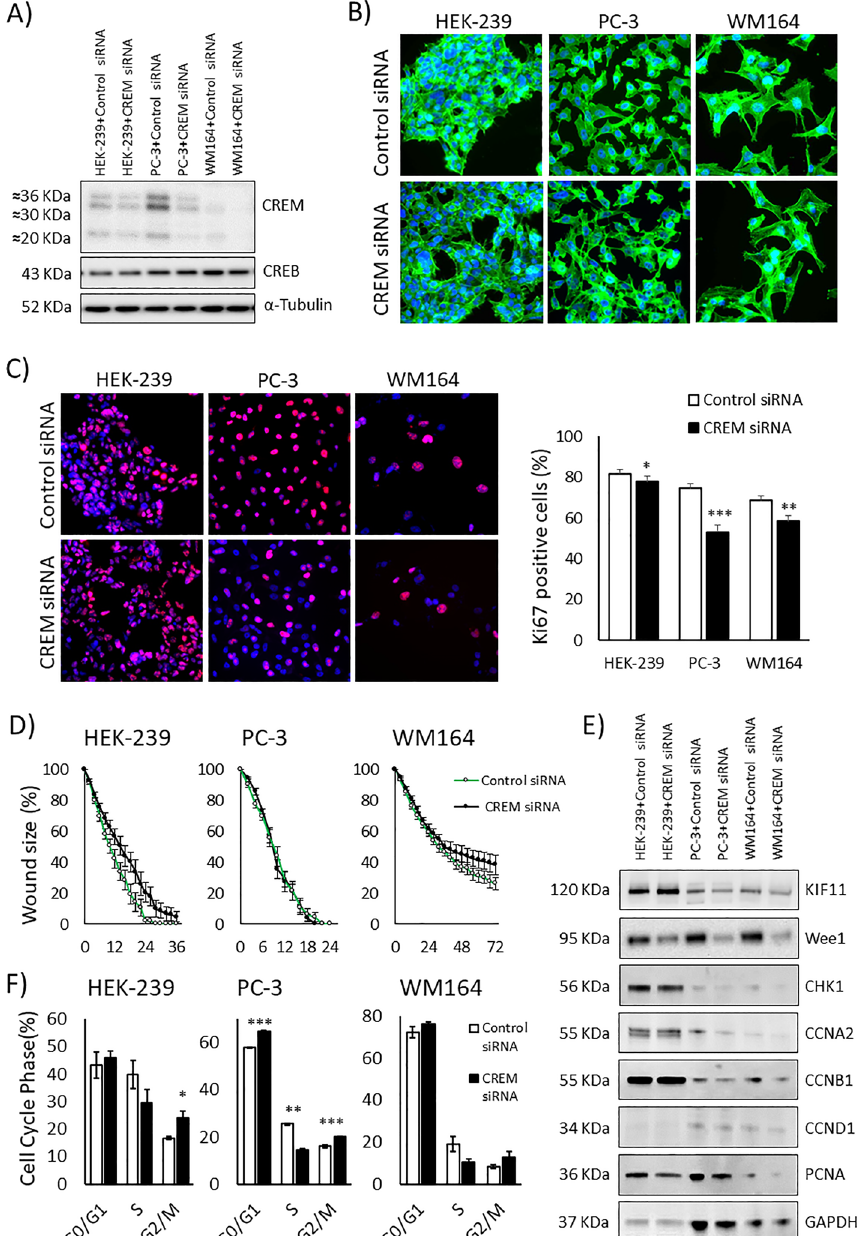
Figure 4. Wild type CREM knockdown. ( A ) Immunoblot showing Wild type CREM knocked down in HEK- 293, PC3, and WM164 after treatment with CREM siRNA for 48 h. The blots are cropped and original blots can be found in Supplementary information—Original blots Supplementary Fig. S8. ( B ) Cell morphology in HEK- 293, PC3, and WM164 cell lines after the reduction in CREM levels. ( C ) Proliferation assessed with Ki67 after CREM siRNA in HEK-293, PC3, and WM164 cell lines, it resulted with proliferation of loss from 82 to 78%, from 75 to 53%, and from 69 to 58%, respectively. ( D ) Wound healing assay to assess migration after CREM knockdown in HEK-293, PC3, and WM164 cell lines. ( E ) Downstream cell cycle related proteins and their expression measured by immunoblotting after CREM knockdown in HEK-293, PC3, and WM164 cell lines. The blots are cropped and CCNA2 was run in lanes with one empty in between so for this image, the empty lane is removed. Original blots/replicates can be found in Supplementary information—Original blots Supplementary Figs. S2, S4, S5, S6 and S7. ( F ) FACS analysis results after CREM siRNA treatment for HEK-293, PC3, and WM164 cell lines. * P ≤ 0.05, ** P ≤ 0.01, and *** P ≤ 0.001 ( t